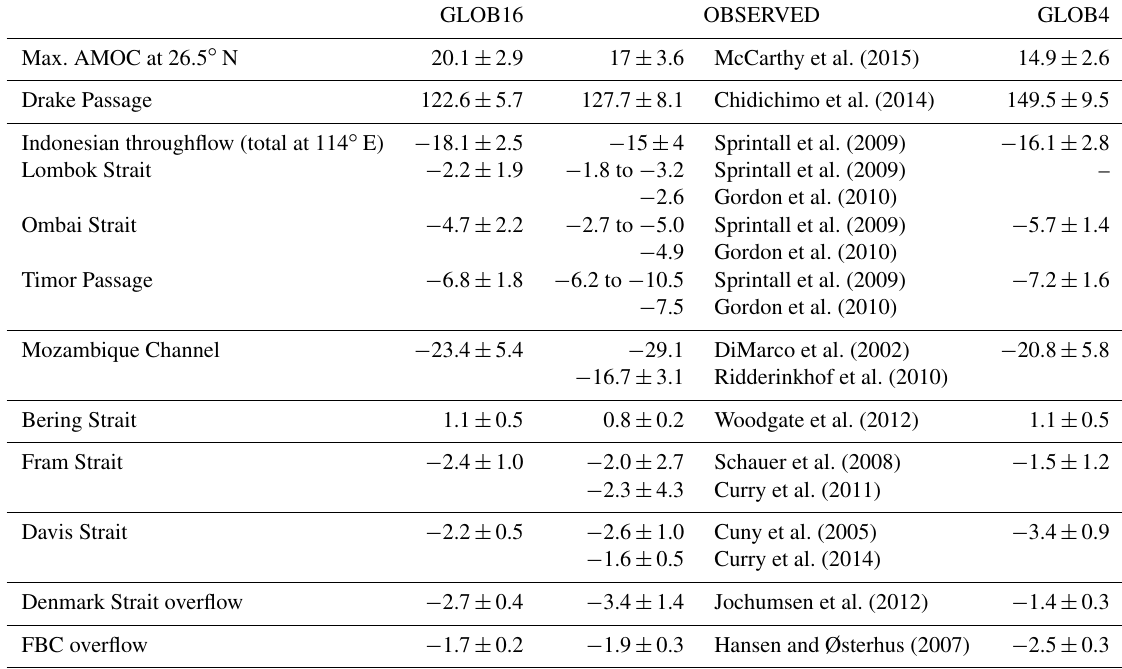
Table 2. Volume transports (in Sv) through key sections, simulated values averaged in the 2004–2013 period and observed mean values with their standard deviations (when available). Positive values correspond to northward and eastward